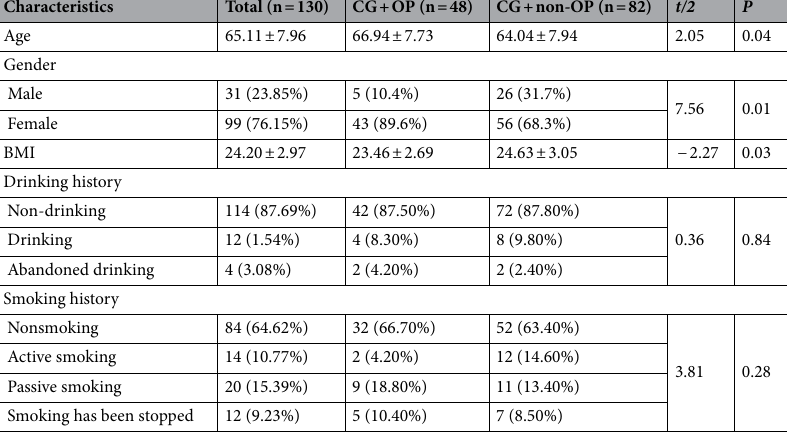
Characteristics